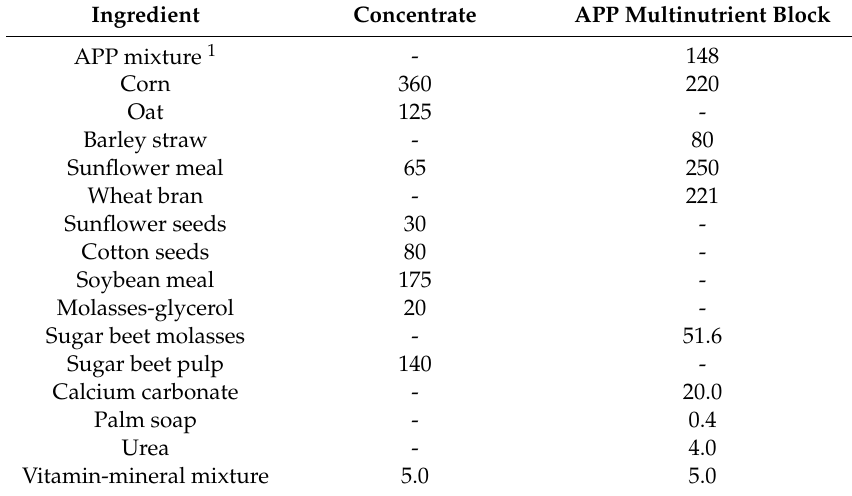
Table 1. Ingredient composition (g / kg fresh matter) of the concentrate and the multinutrient block including a mixture of avocado pulp and peels (APP) fed to dairy goats. Ingredient Concentrate APP Multinutrient Block APP mixture 1 - 148 Corn 360 220 Oat 125 - Barley straw - 80 65 250 Wheat bran - 221 30 - - - - - 140 -